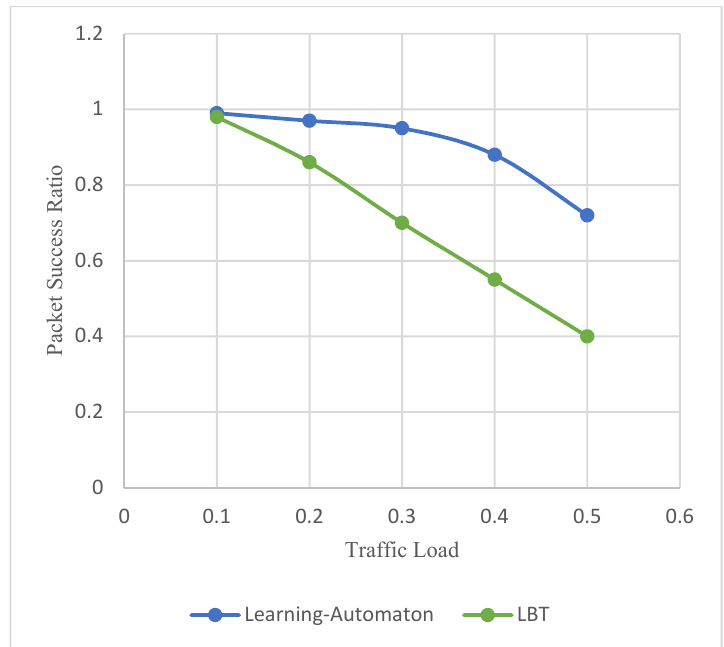
Figure 6. Average collisions versus traffic load.